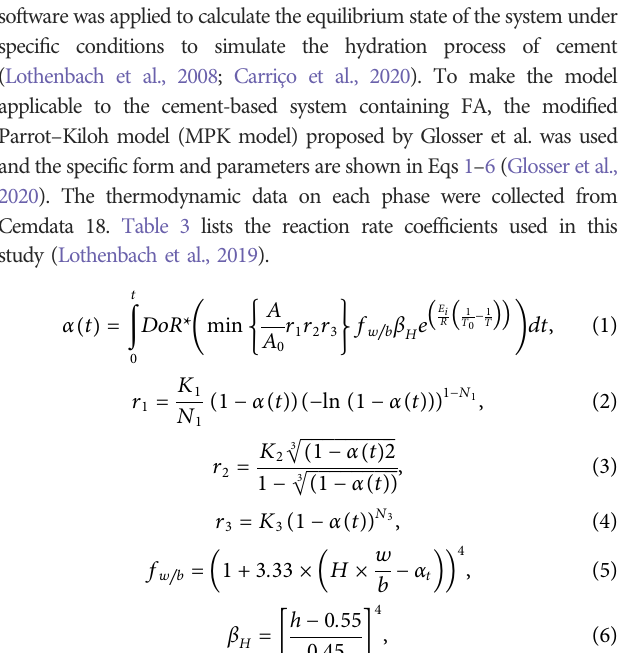
TABLE 2 Compositions of cementitious materials (%).